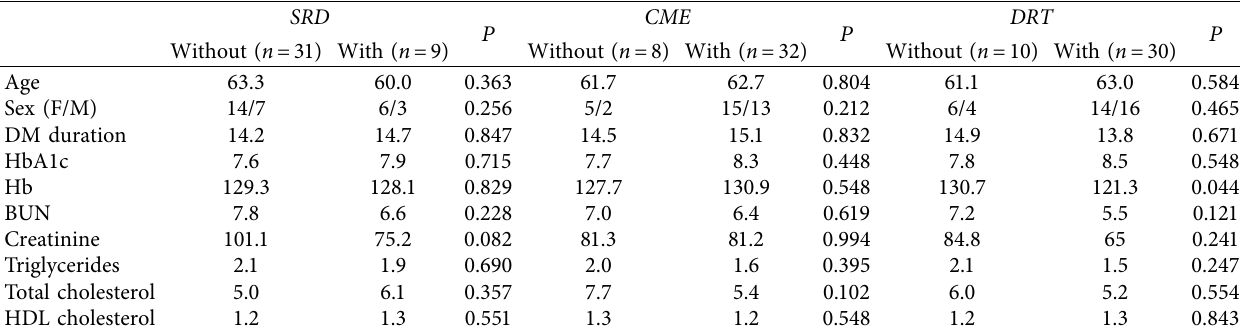
Figure 1: OCT images of diferent DME types. (a) DME primarily exhibits DRT, with macular spongy thickening indicated by ar- rowheads; (b) DME primarily exhibits CME, with intraretinal hyporefective cystic cavity indicated by arrows; (c) DME primarily exhibits SRD, with an optically clear gap between retinal neuroepithelium and pigment epithelium indicated by asterisks; (d) DME exhibits CME and DRT; (e) DME exhibits DRT and SRD; (f) DME consists of a mixture of CME, DRT, and SRD types. Table 1: Comparison of baseline characteristics in patients with diferent types of